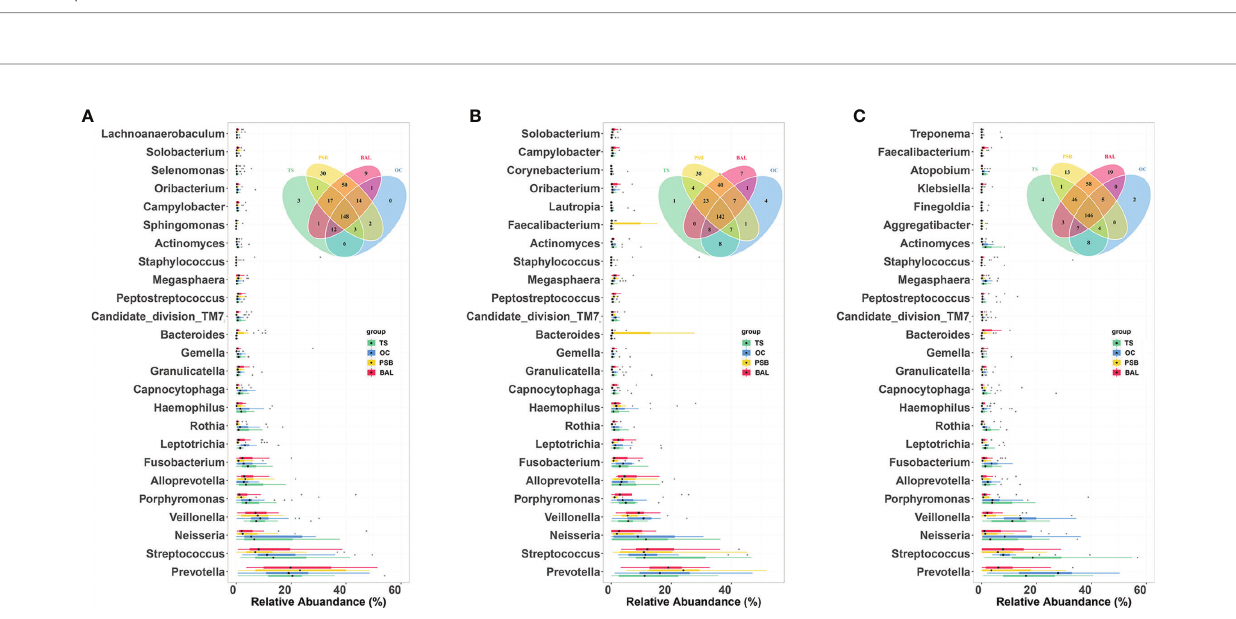
FIGURE 3 | Unweighted UniFrac principal coordinate analysis of microbiota from (A) OC, (B) throat swab, (C) PSB, and (D) BALF samples between NMTT, SGC and SCC patients.